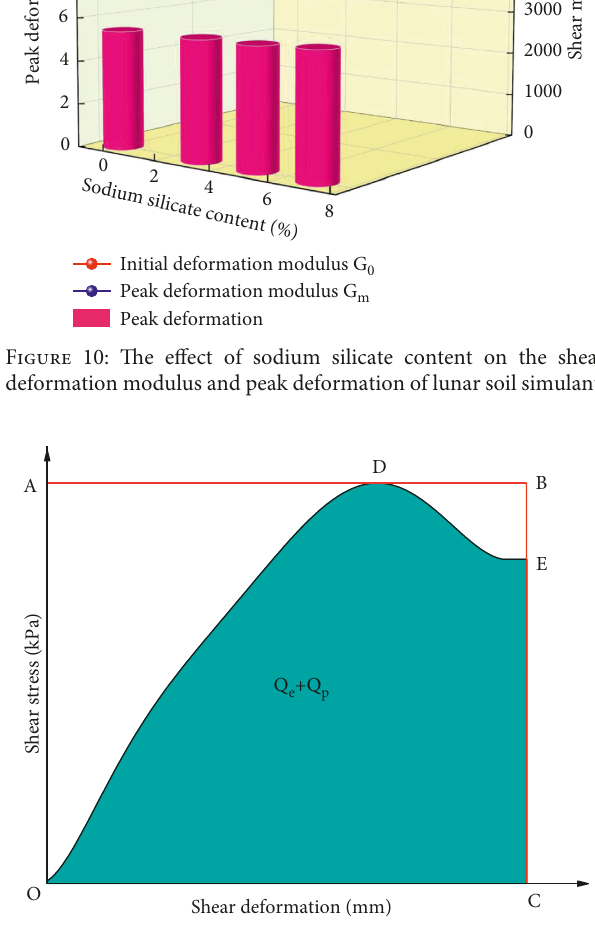
Figure 11: Force state of specimen during direct